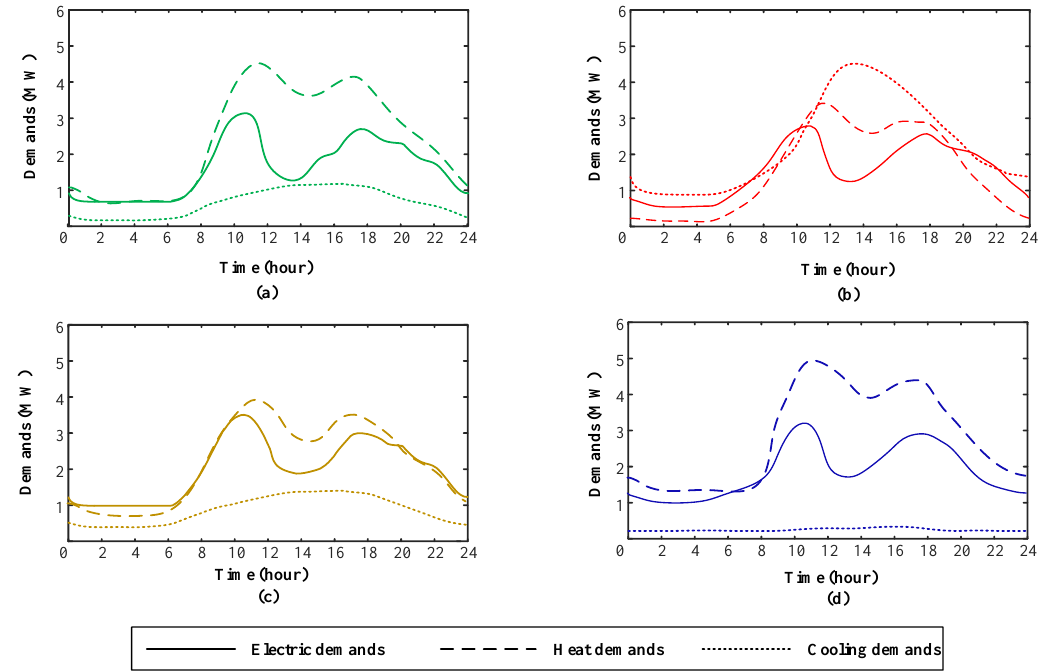
Figure 4. Seasonal cooling, thermal, and electrical load curves of the integrated energy system.